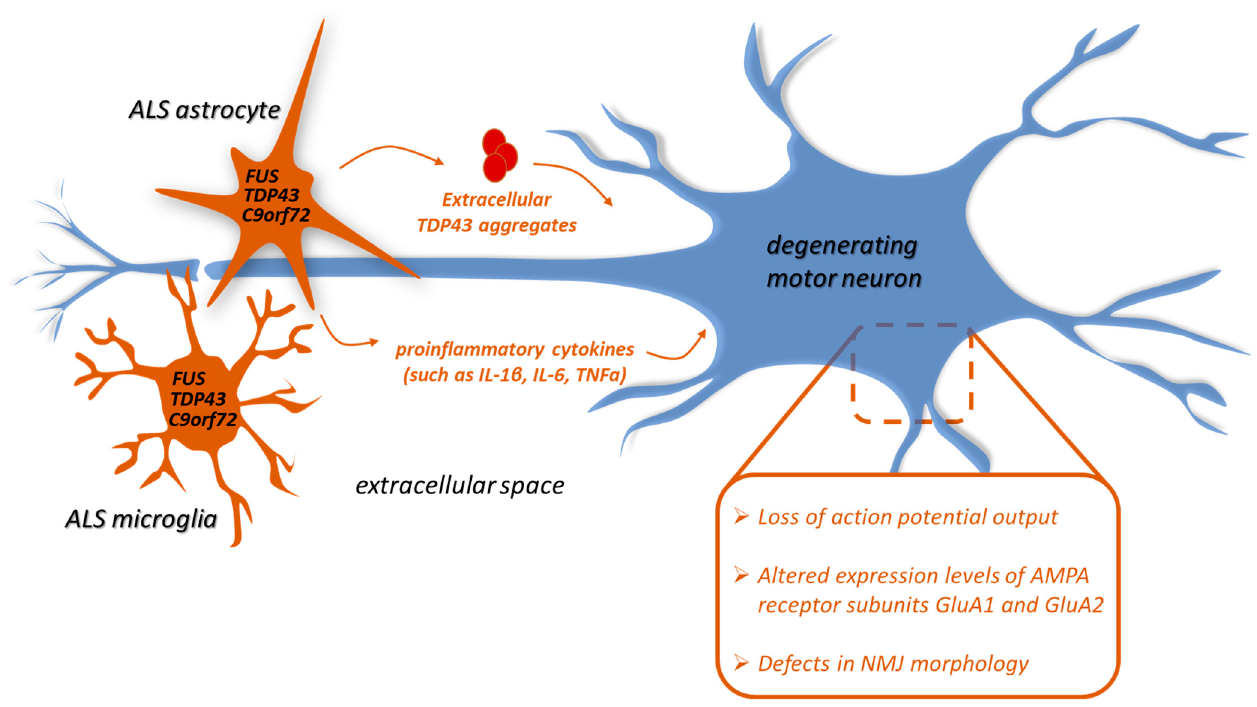
Figure 1. Non - cell-autonomous mechanisms underlying motor neuron degeneration mediated by ALS-linked C9orf72, FUS, or TDP-43 astrocytes and microglia. Wild-type motor neurons undergo cell death when co-cultured with astrocytes or microglia expressing ALS-linked C9orf72, FUS, or TDP-43. Mechanisms underlying non-cell-autonomous toxicity include loss of action potential output, altered expression levels of AMPA receptor subunits GluA1 and GluA2, and defects in neuromuscular junction (NMJ) morphology. These effects could be mediated by the extracellular secretion from glial cells of proinflammatory cytokines, such as IL-1 β , IL-6, and TNFa, or TDP-43 aggregates.